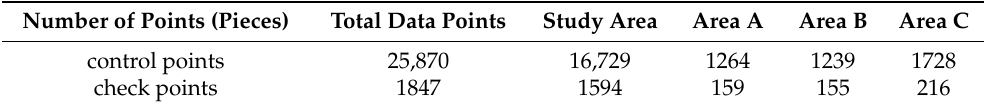
Table 1. Visual statistics of the number of control points and check points in each region. Number of Points (Pieces) Total Data Points Study Area Area A Area B control points 25,870 check